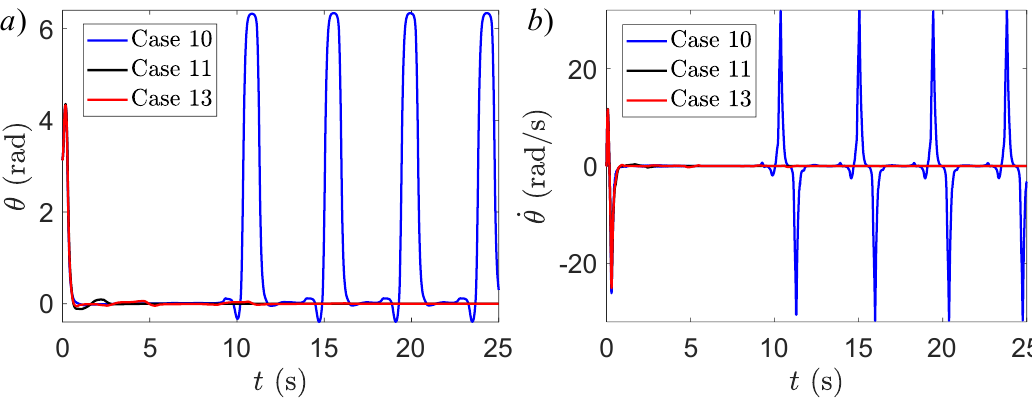
Figure 12. Cart position and velocity for Cases 10, 11, and 13. ( a ) Cart position during the swing-up task. ( b ) Cart velocity during the swing-up task.